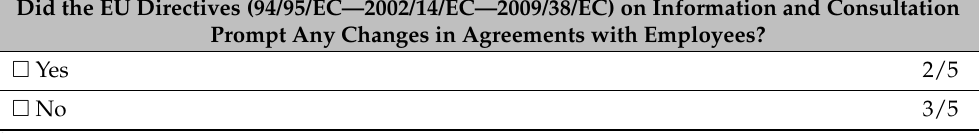
Table 10. Impact of EU Directives (94/45/EC—2002/14/EC—2009/28/EC) on agreements with employees.